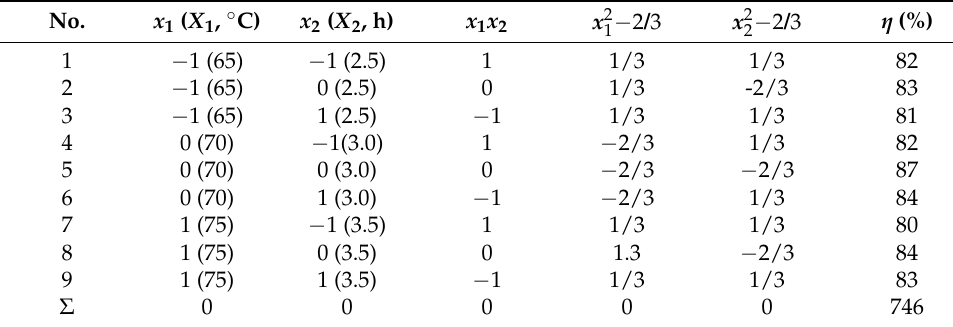
Table 2. E xperiment 3 2 for molecule